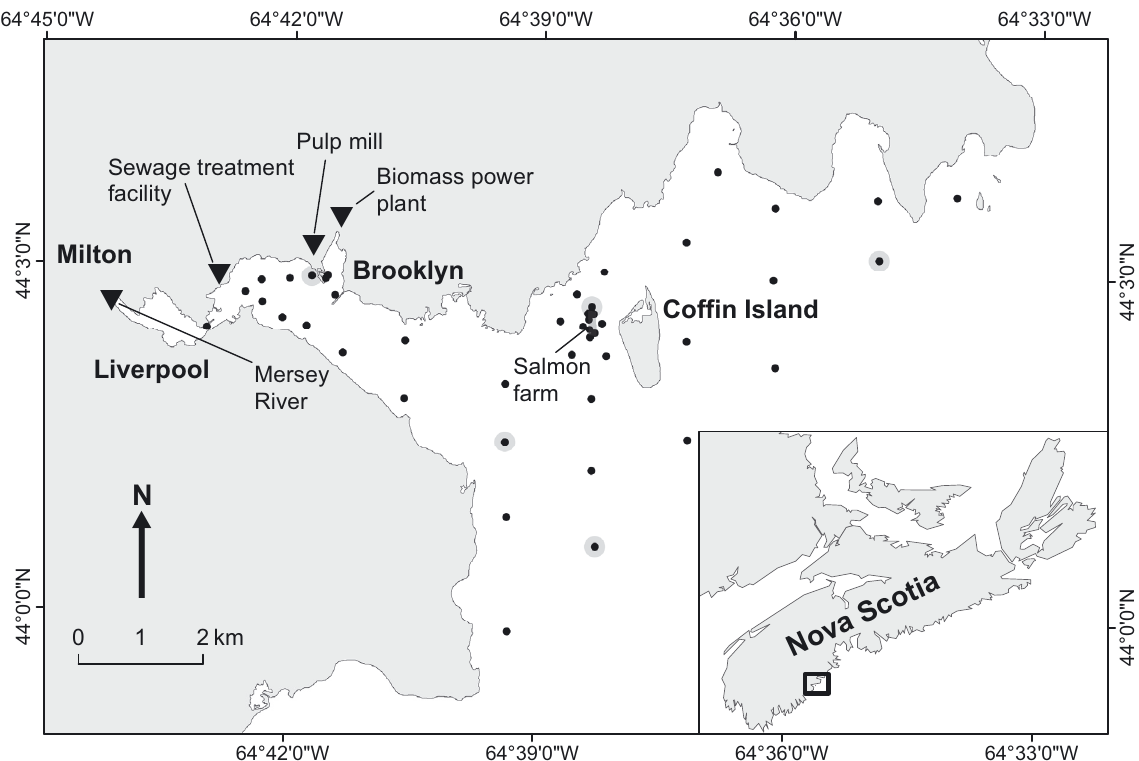
Fig. 1. Liverpool Bay, Nova Scotia, Canada, indicating towns, key geographical features and probable point sources. Points indi- cate the locations of the deployments of the macroalgae Chondrus crispus and Palmaria palmata . Grey circles indicate stations where surface water samples were